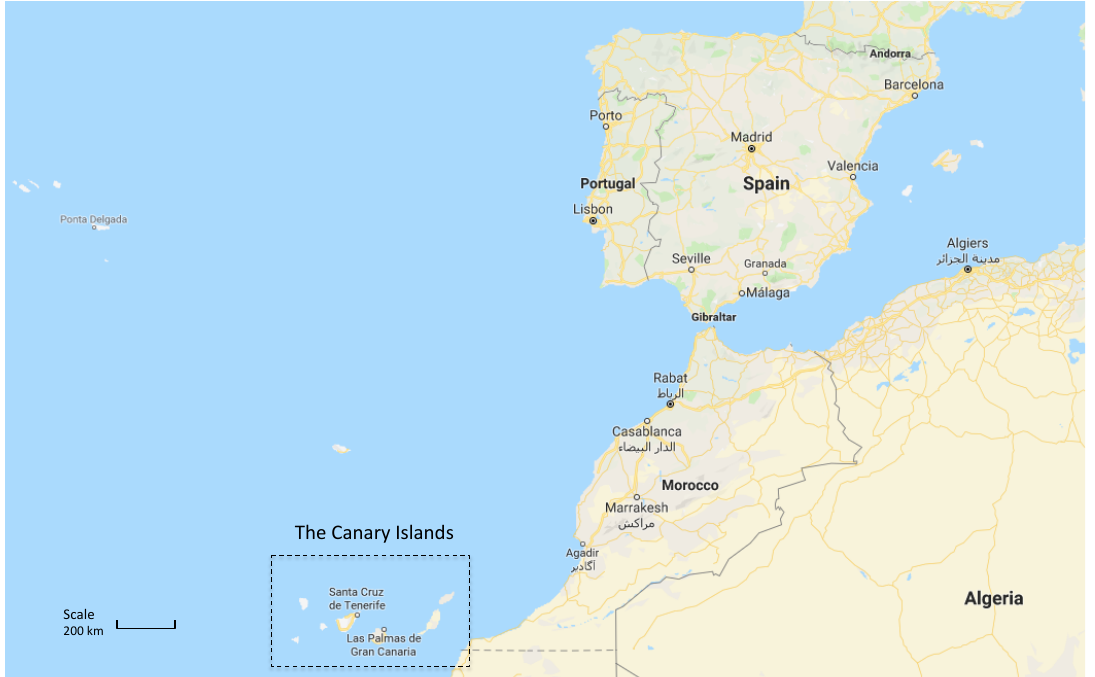
Figure 1. Map of the location of the Canarian archipelago. Source: Google Maps.